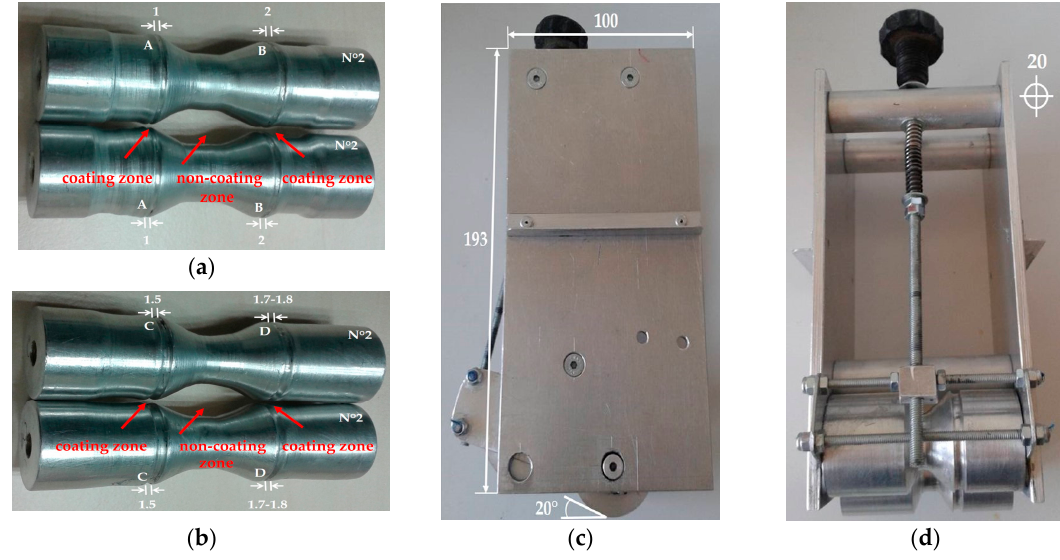
Figure 9. Roll to roll aluminum laboratory device parts: ( a ) rollers N ◦ 2 with notch widths A-A and B-B; ( b ) rollers N ◦ 2 with notch widths C-C and D-D; ( c ) lateral view and ( d ) front